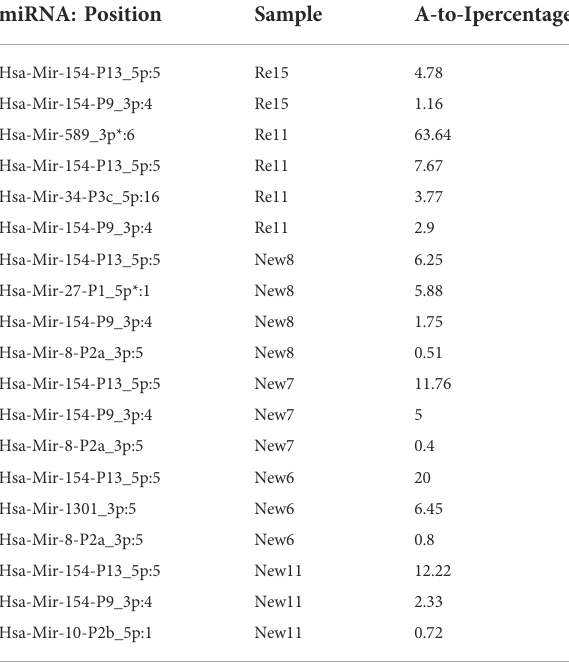
TABLE2OverviewofallmiRNAeditingeventsof10caseswithmRNA- seq results.